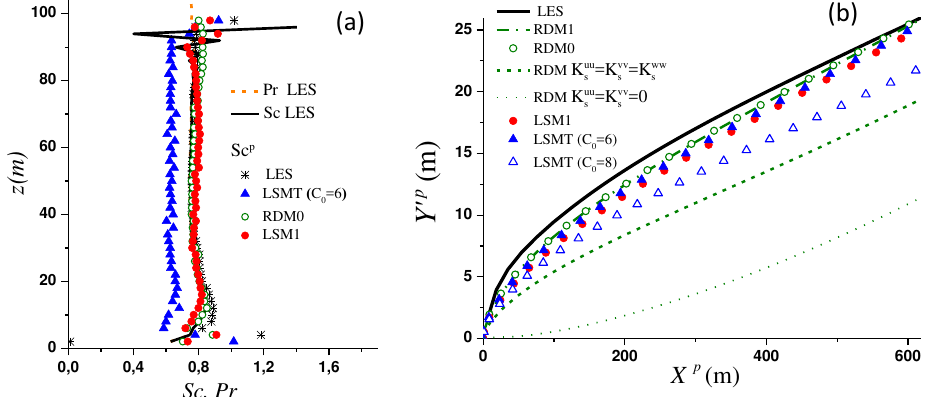
Figure 12. (a) Prandtl number Pr (dashed line) and Schmidt number Sc (solid line), computed using Eulerian scalars. Symbols – Schmidt numbers Sc , computed using the Lagrangian particles in LES, LSMs and RDMs. (b) RMS of the crosswind position of parti- D E 1 / 2 (y p − Y p ) 2 cle Y (cid:48) p = depending on the mean longitudinal position X p = (cid:10) x p (cid:11) . Dashed lines – RDM with K uu s = K yy s = K ww s and one-dimensional RDM K uu s = K vv s =